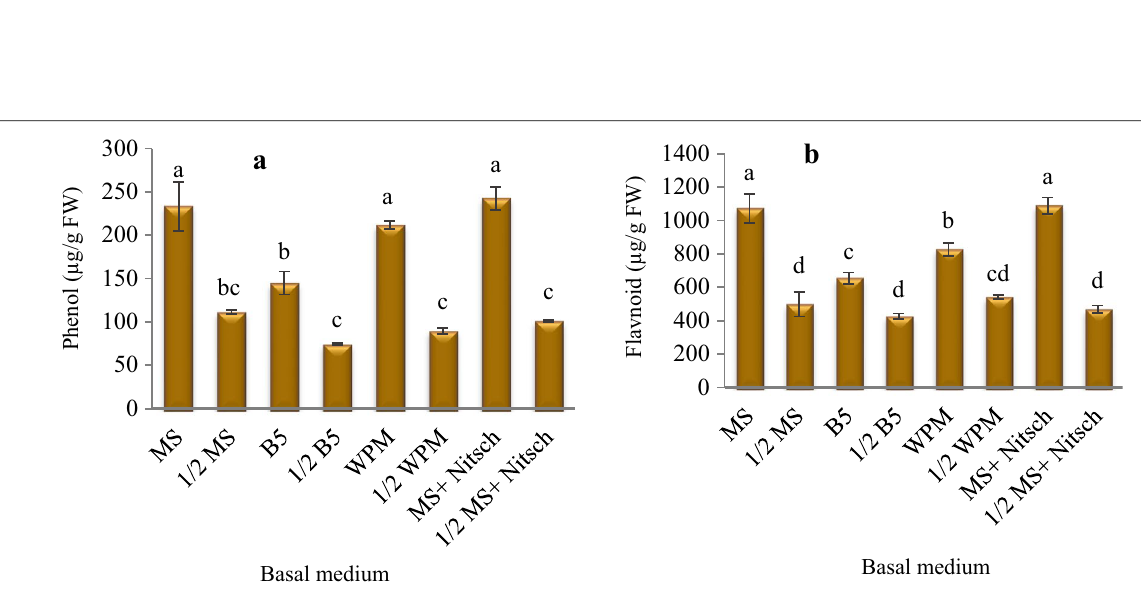
Fig. 7 The influence of the basal medium on total phenolic ( a ) and flavonoid ( b ) content in the Corylus avellana callus cultures. According to Duncan’s multiple range tests, values with common letters are not significantly different at the 5% probability